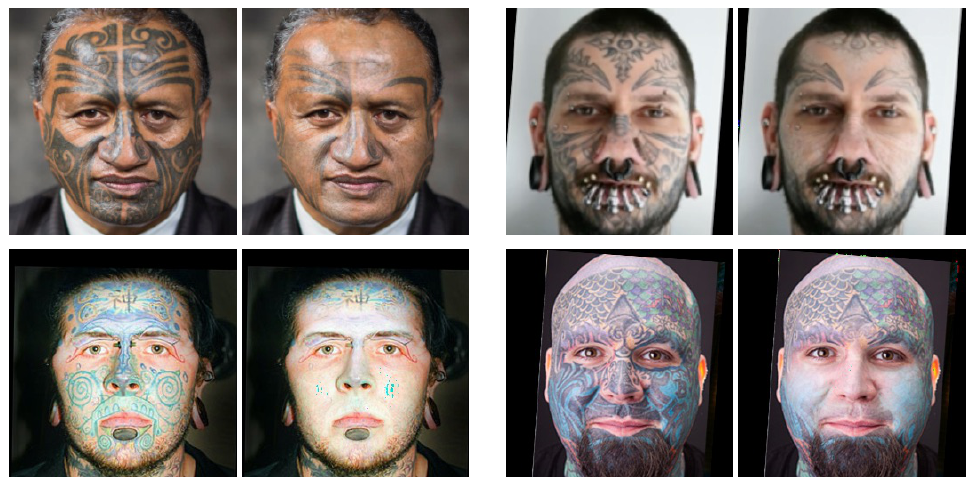
Figure 15. Facial images with extreme coverage of tattoos, which remain challenging for our tattoo removal approach. Before ( left ) and after ( right ) tattoo